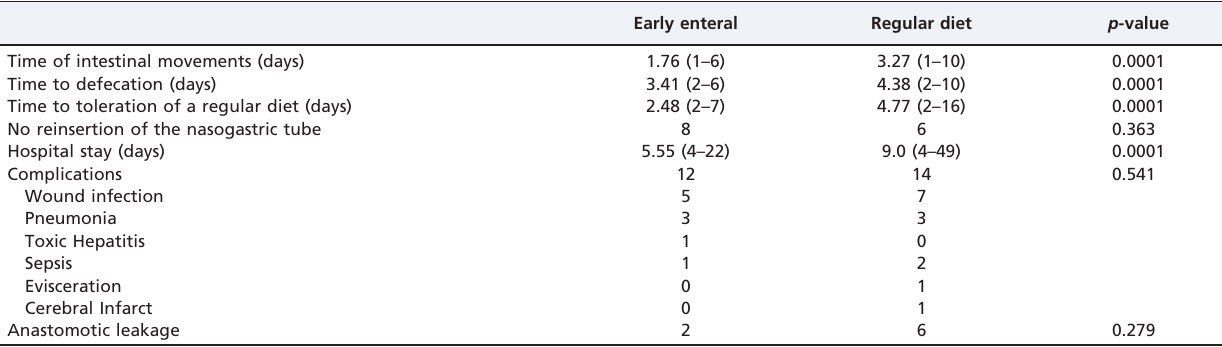
Table 2 - Gastrointestinal recovery parameters and postoperative